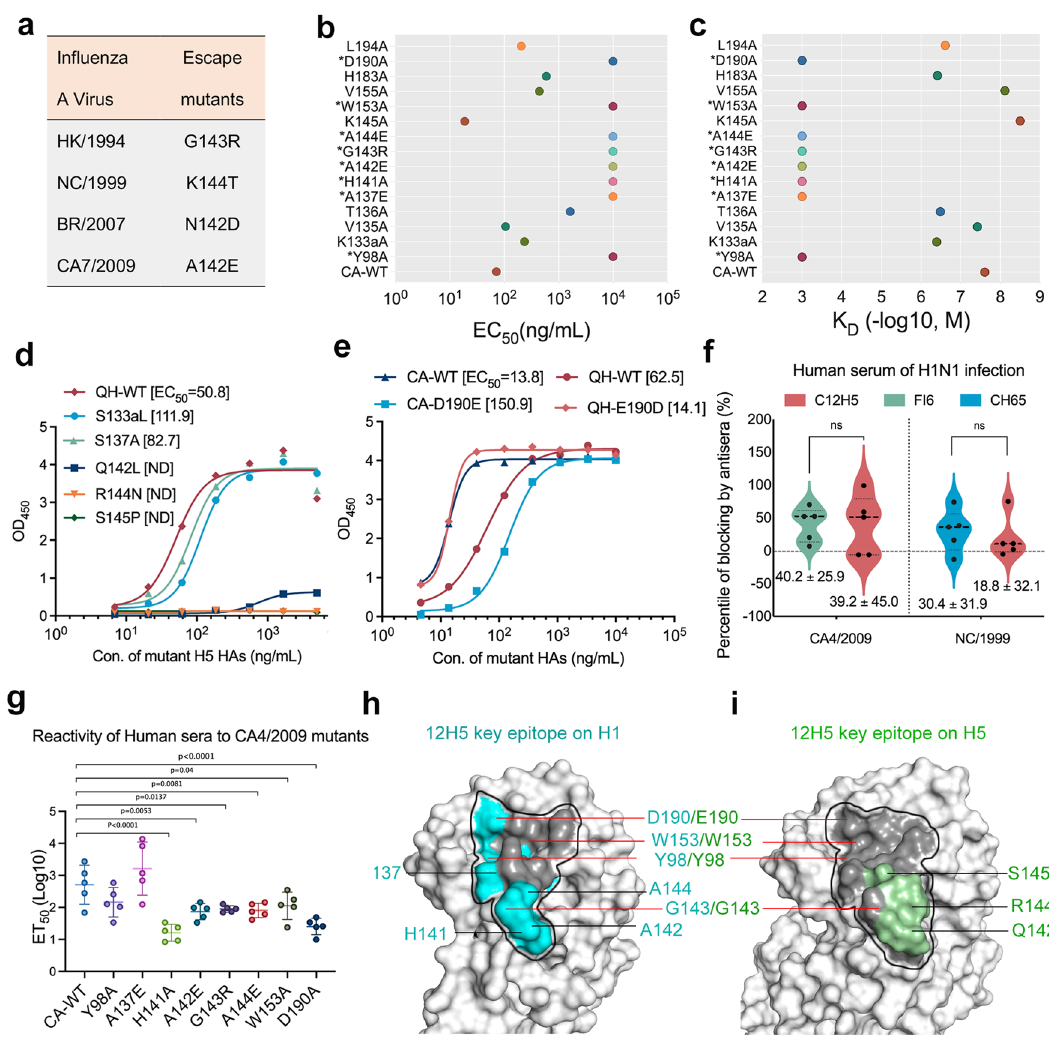
Fig. 7 | Interaction analysis and mutagenesis for the epitope of 12H5. a Amino acid substitutions found in the HA of C12H5-induced escape mutants with four in fl uenza A strains. b Reactivity pro fi les of CA HA and its mutants against C12H5 antibodies measured through sandwich ELISA. The EC 50 values were calculated by sigmoid fi tting,asshowninSupplementaryFig.11.EC 50 valuesareplottedascircles along the horizontal axis for each protein. c Binding af fi nity measurements for HA and its mutants against C12H5, as determined with SPR. The kinetic constants between C12H5 and Y98A, A137E, H141A, A142E, G143R, A144E, W153A, and D190A mutantswerenotdeterminable.Thecalculatedaf fi nityconstantsand fi ttingresults are shown in Supplementary Table 8 and Fig. 11. The EC 50 and K D values in b and c are averaged data from two independent experiments. d Comparison of binding reactivityof fi vevariantsiteswiththemutantsandwildtypeofQH/2005HAintwo